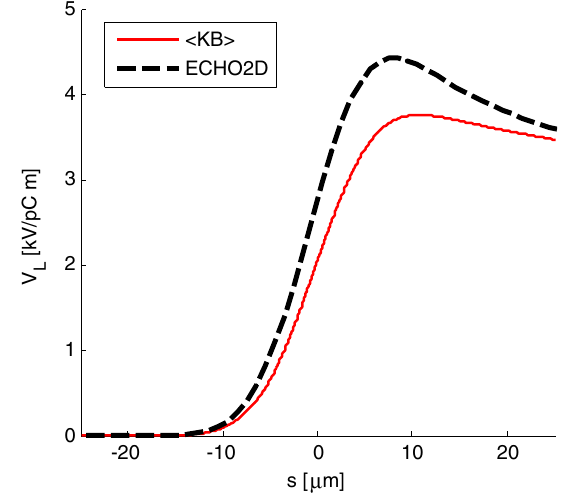
FIG. 2. Short-range longitudinal wake potential for a bunch ¼ 5 (cid:2) m in the sample structure (Fig. 1) were calculated of (cid:1) z using the h KB i model (solid line) and the ECHO2D code (dashed